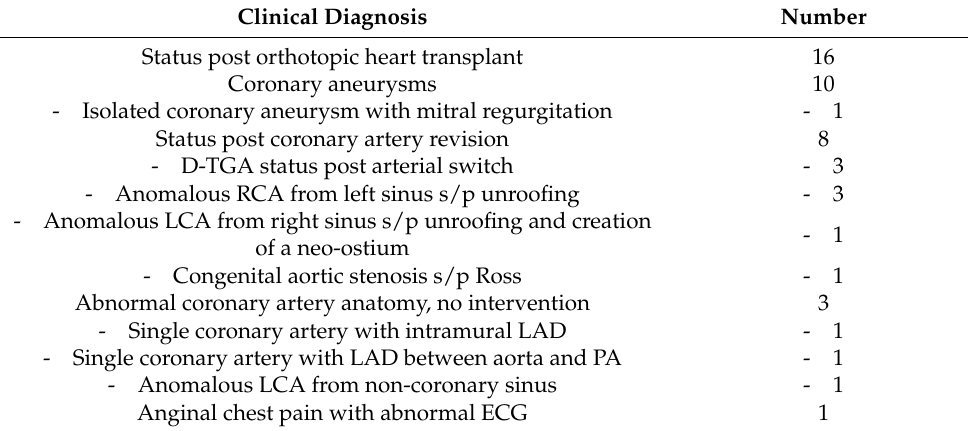
Table 1. Clinical diagnosis of 38 patients undergoing stress perfusion